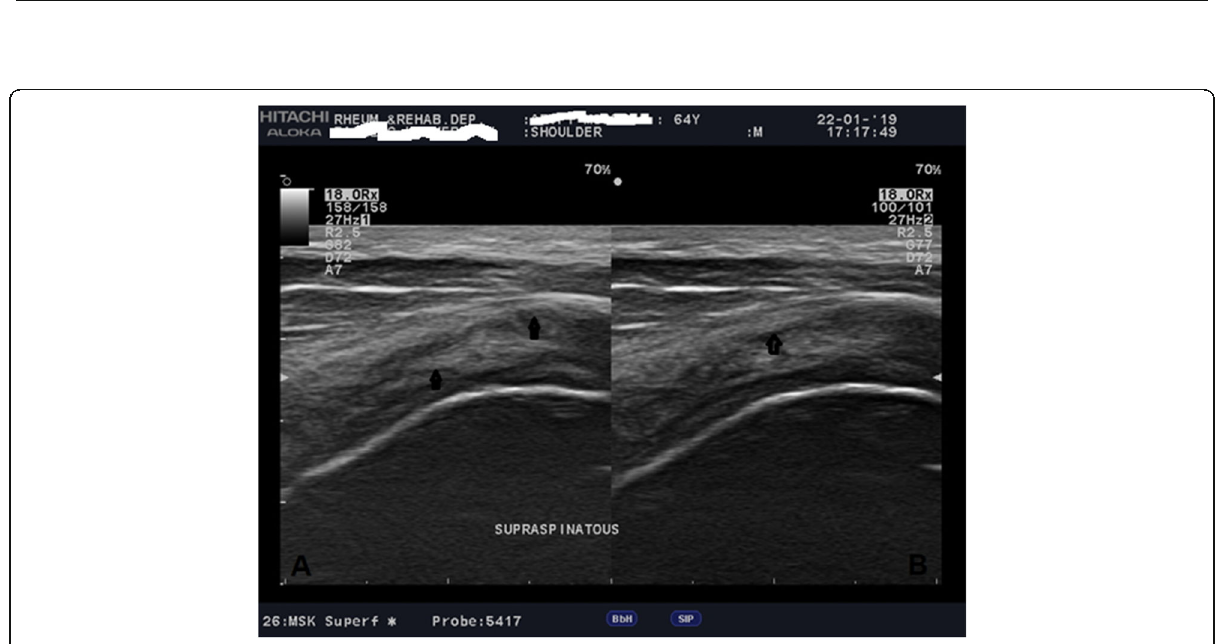
Fig. 2 Left supraspinatus tendinopathy. a Longitudinal view. b Transverse view of the left supraspinatous tendon of the left shoulder joint. Arrows showed architectural distortion with loss of the normal fibrillar